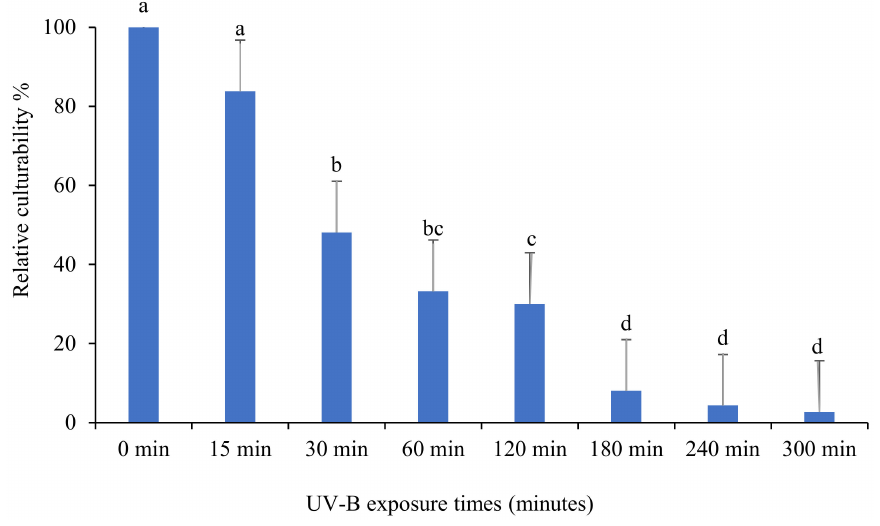
Figure 2. The impact of different UV-B exposure times on relative culturability percentage of Beauveria bassiana isolate “BbSA-1”. The mean number of relative culturability percentage ± SE is shown. Different letters on the same patterned bars indicate significant differences (LSD test, p < 0.05).